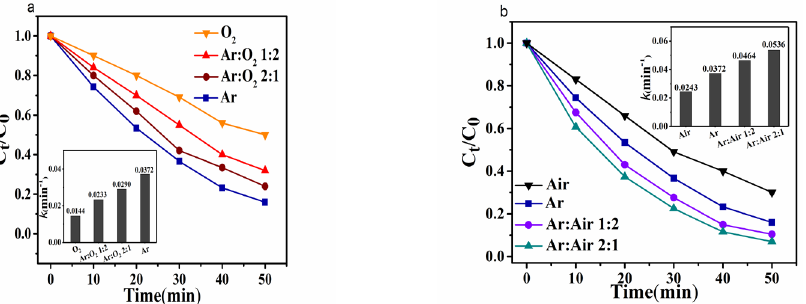
Figure 6. ( a ) The degradation efficiencies and kinetic constants of PFOA in O 2 , Ar and mixtures of O 2 and Ar; ( b ) The degradation efficiencies and kinetic constants of PFOA in the air, Ar and mixtures of air and Ar; Experimental conditions: the power supply: negative pulse power supply; peak volt- age: 12 kV; power frequency: 6 kHz; pulse width: 500 ns; average power: 22